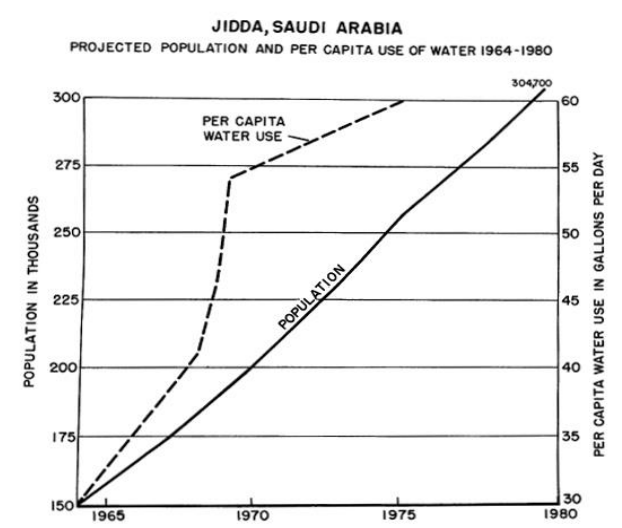
Figure 1: Water demand and population projections from the OSW’s 1964 Jidda, Saudi Arabia Water Study .